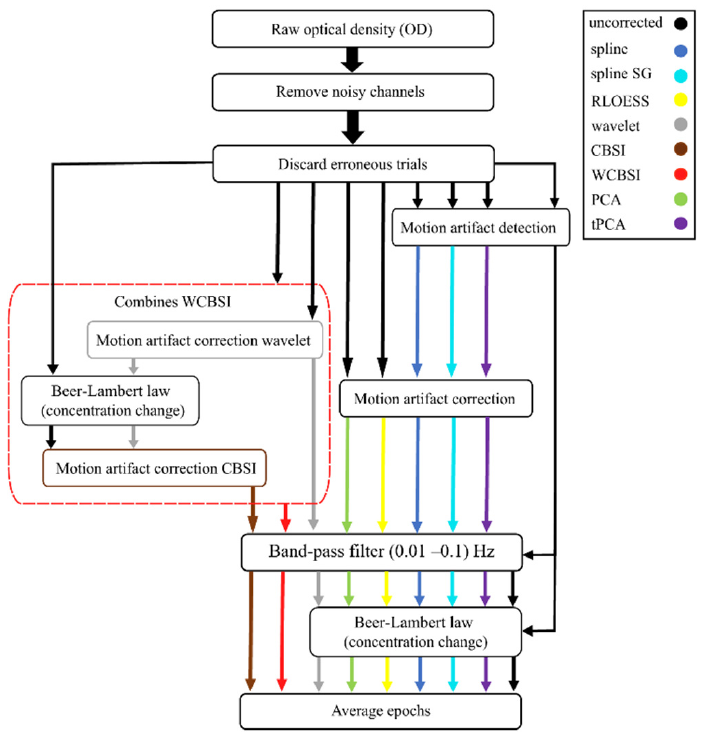
Figure 1. The flow of data for all MA correction techniques tested here. The rounded rectangles indicate the processing steps applied to the data. The data flow of each technique is indicated by color-coded arrows: black for uncorrected data, blue for spline, cyan for spline SG, yellow for RLOESS, gray for wavelet, brown for CBSI, green for PCA, purple for tPCA, and red for WCBSI correction. The red dashed box indicates how processes are combined in the WCBSI correction. All parameters used in the respective MA correction algorithms are listed in Table